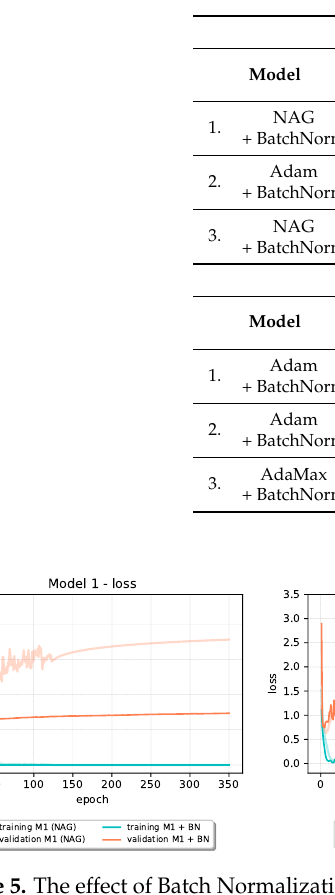
Figure 5. The effect of Batch Normalization on the loss of baseline models trained on CIFAR-10 dataset.